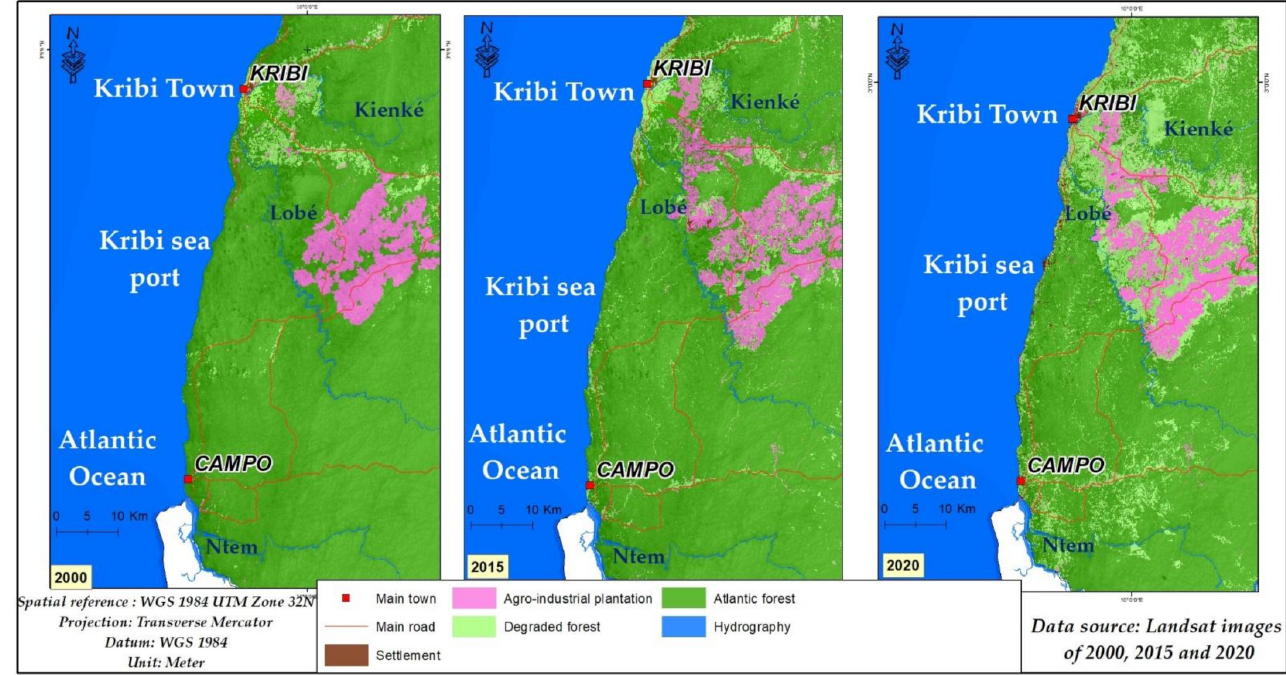
Figure 6. Evolution of land use on the Kribi-Campo coast between 2000 and